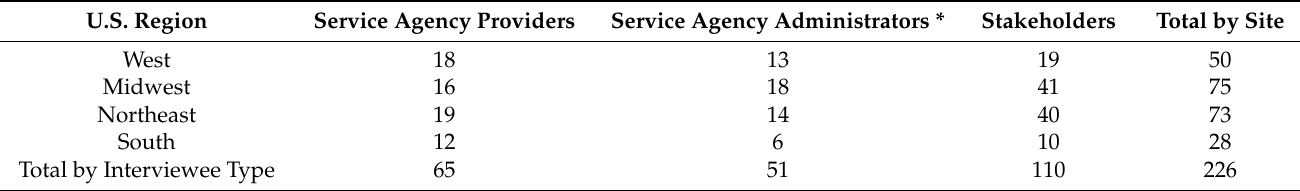
Table 1. Interviewee type by state—wave 1–3 (July 2014–August 2016). U.S.